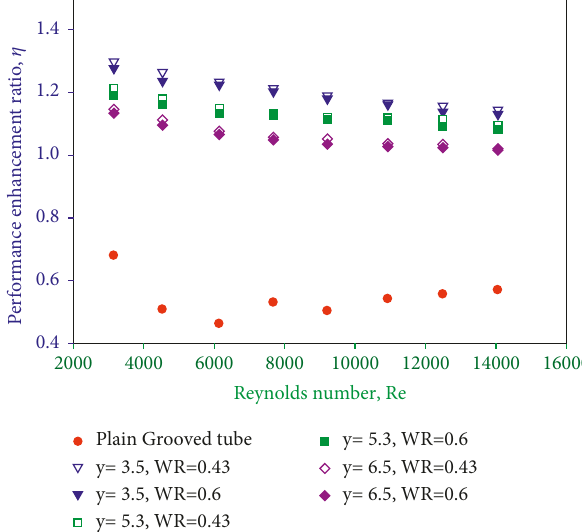
Figure 10: Performance enhancement ratio ( η number